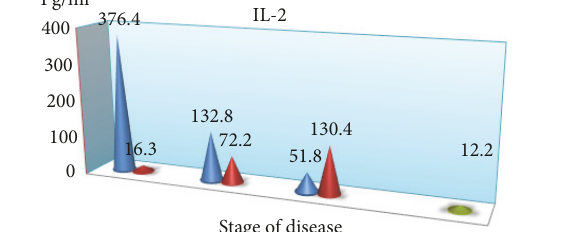
Figure 6: Dynamics of indicators of proinflammatory cytokines antagonists (IL-2) in children with